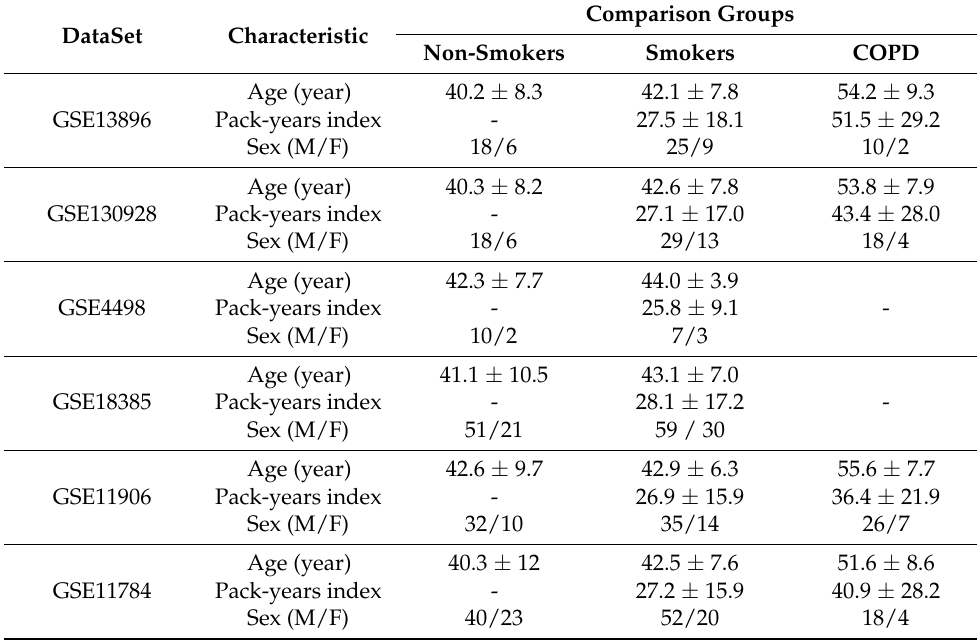
Table 2. Demographic and clinical characteristics of patients in GEO datasets. DataSet